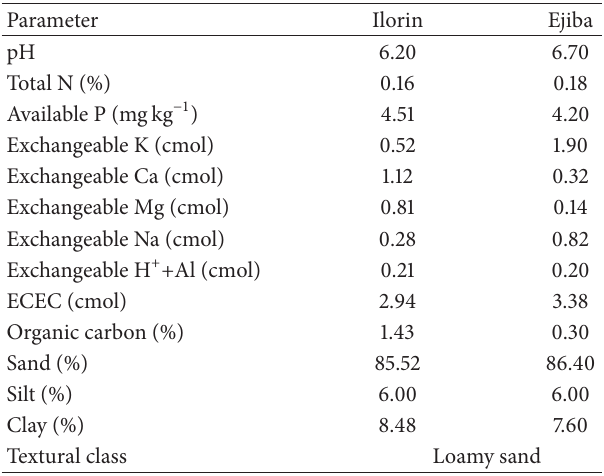
Table 1: Soil physicochemical characteristics of Ilorin and Ejiba experimental